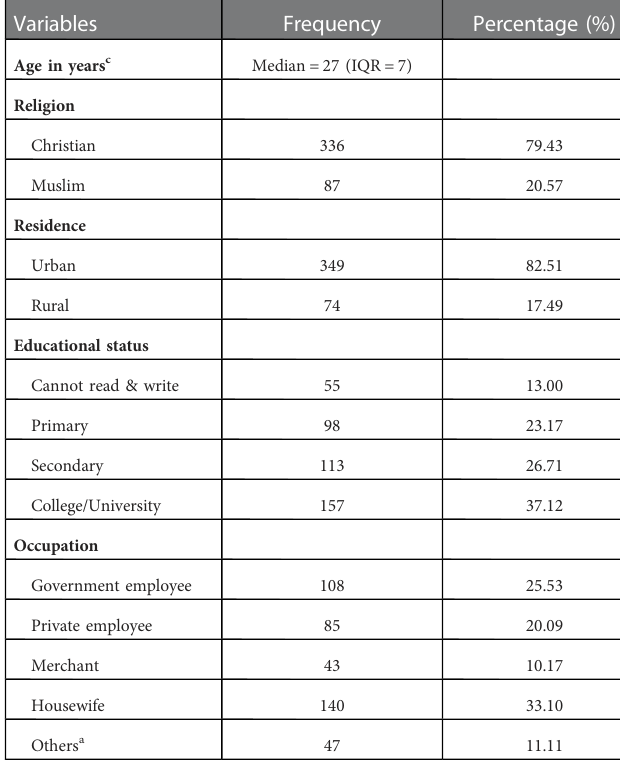
TABLE 1 Socio-demographic characteristics of pregnant women attending ANC units at governmental health institutions in Gondar District, Northwest Ethiopia, 2021 ( n